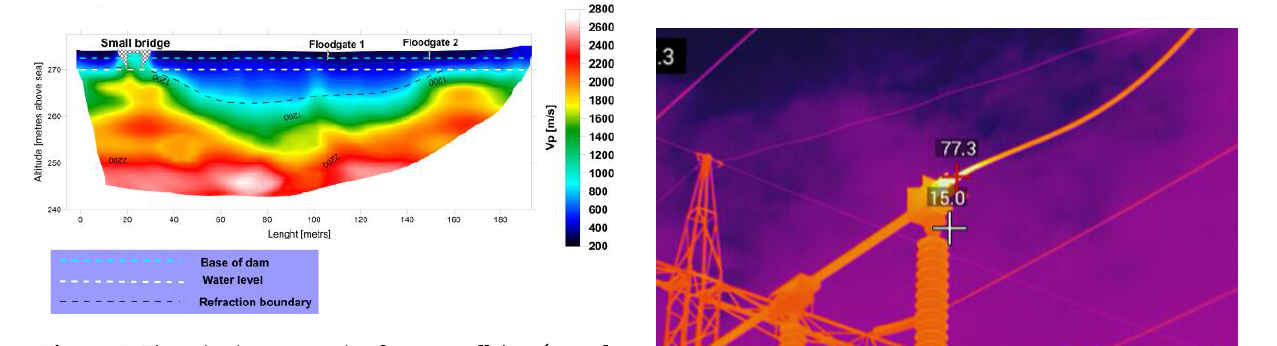
Figure 17. The seismic cross section from a small dam (central territory of the Czechia).